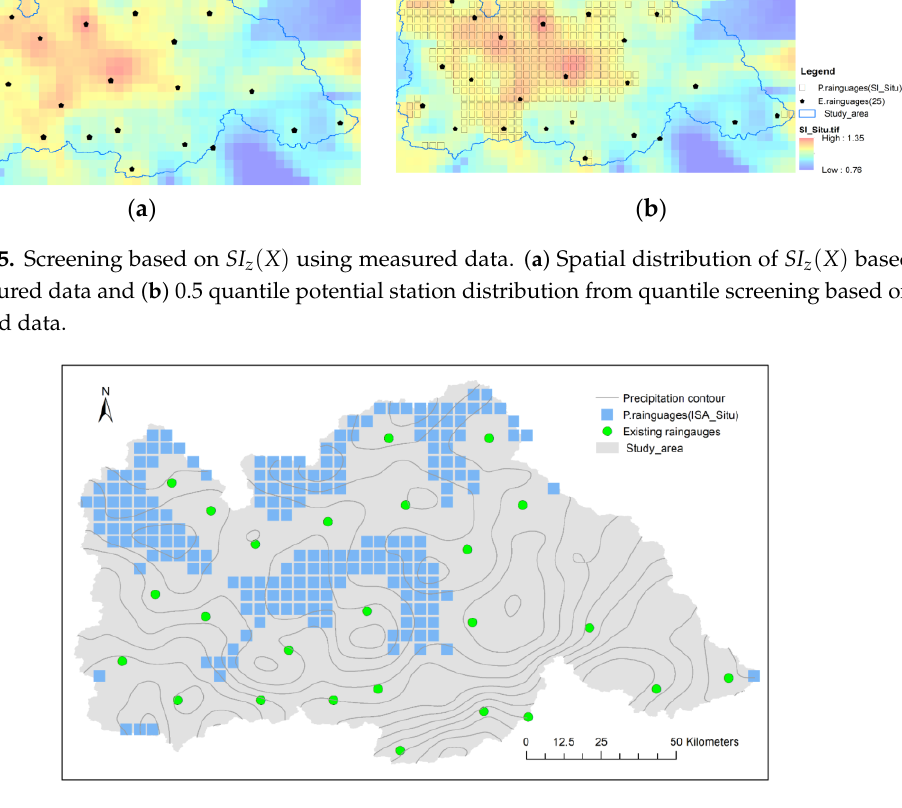
( b ) Figure 17. Optimal design of the S-ISA method. ( a ) Network of 60 rain gauges and ( b ) network of 45 rain gauges. Figure 18, which is similar to Figure 14 in the previous section, is based on the performance of the two methods. ( a )